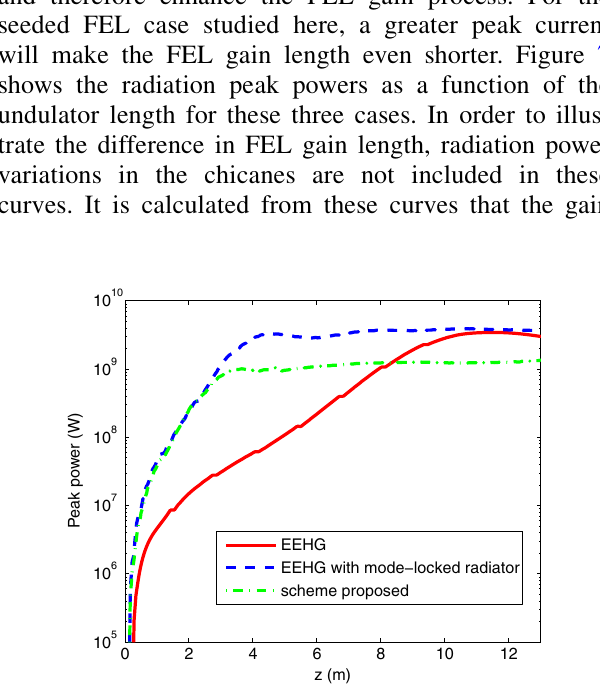
FIG. 7. Radiation peak power as a function of undulator length (radiation power variations in the chicanes of each module is not drawn) for the three cases: EEHG without a mode-locked radiator (red solid curve), triple-modulator scheme with seed3 off (blue dashed curve), and triple-modulator scheme with seed3 on (green dot-dashed